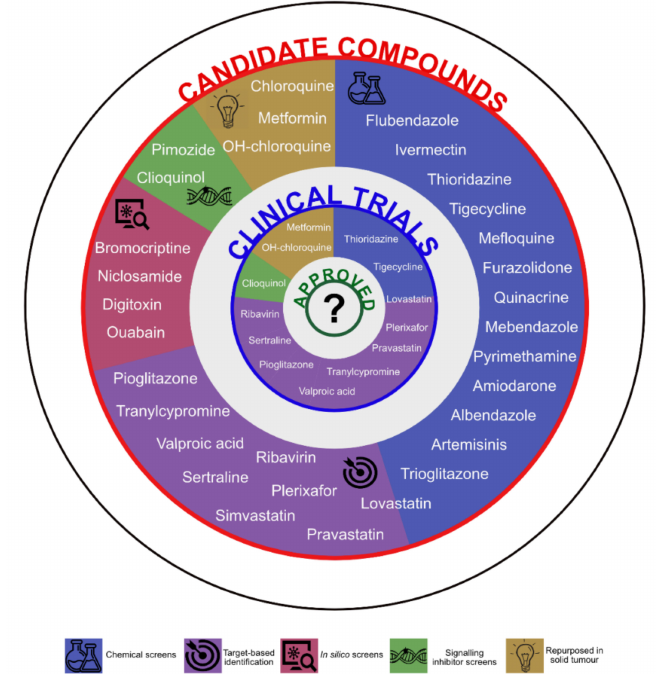
Figure 1. Candidate compounds to treat acute myeloid leukaemia (AML) obtained through a host of methods tested in preclinical (outer circle) and clinical setting (inner